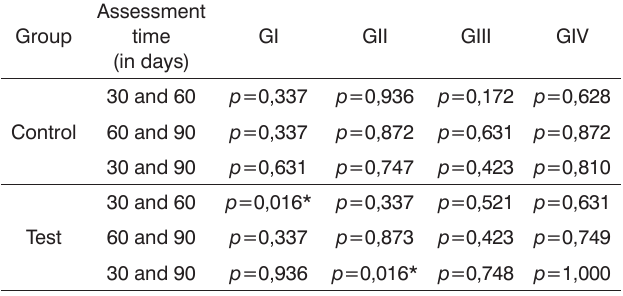
Table 1. Test and control groups’ histomorphometric assess- ment by assessment time and according to the tested material. Assessment Group